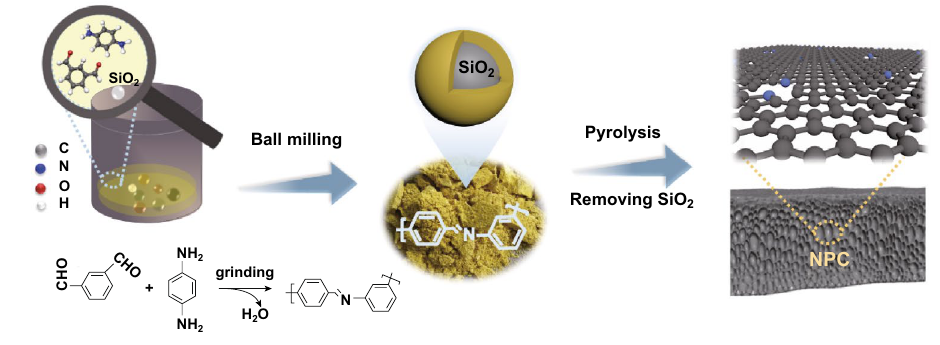
Fig. 1 Schematic representation of the preparation of N-doped porous carbon (NPC) via a mechanochemical route